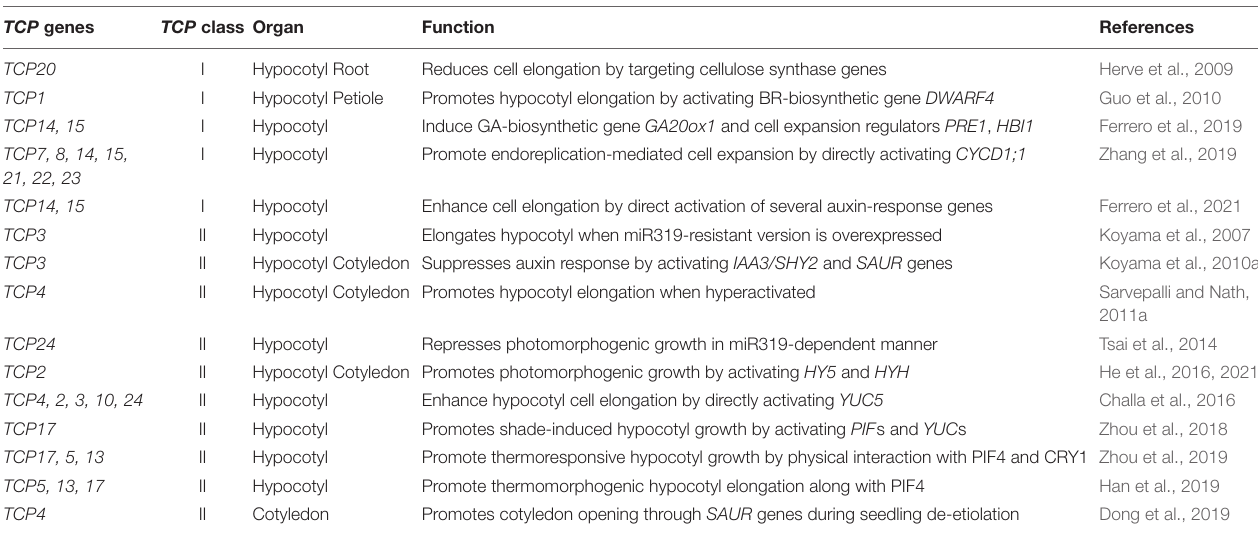
TABLE 1 | TCP genes implicated in cell growth in Arabidopsis thaliana embryonic